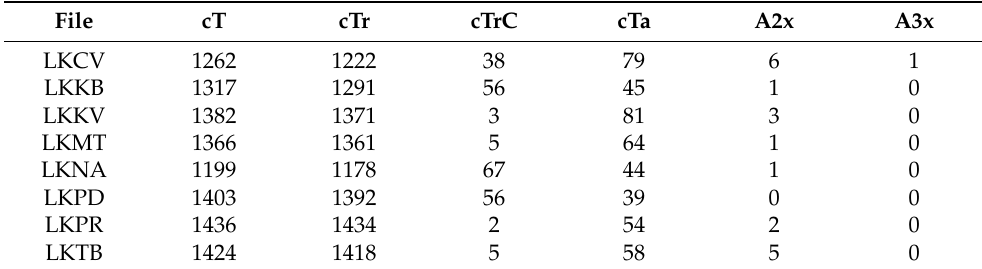
Table 9. Total number of dates used in the TAF assessment.